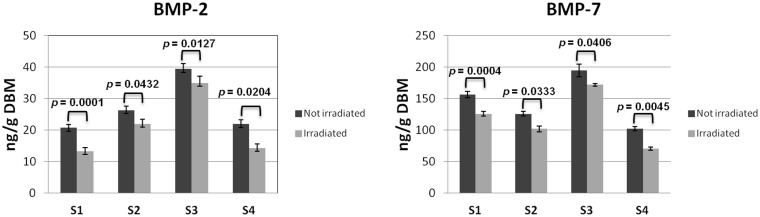
Concentration of BMP-2 (left) and BMP-7 (right) in gamma irradiated and not irradiated samples (*p<0.05).